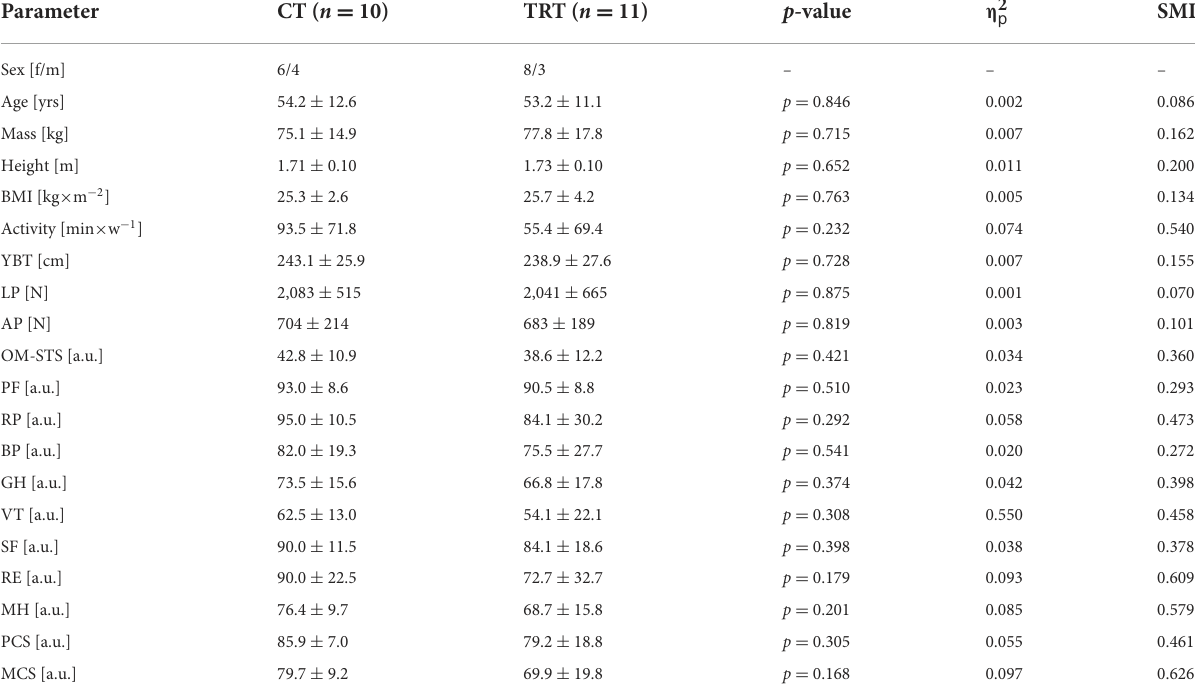
TABLE 1 Mean values ± standard deviations for anthropometric data, performance indices and items of the SF-36 questionnaire of both cluster training (CT) and traditional training group (TRT) at PRE. Parameter CT ( n = 10) TRT ( n = 11) p -value η 2 p SMD Sex [f/m] 6/4